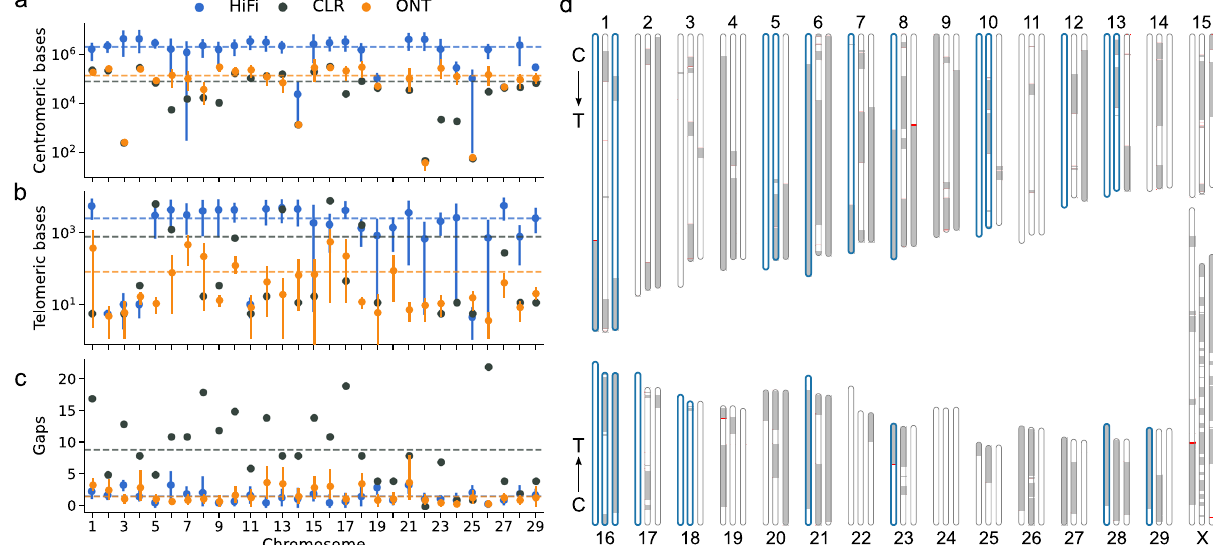
Fig. 2 Centromeric and telomeric completeness of assemblies produced by hi fi asm and Shasta. a The mean number of bases identi fi ed per autosome as “ Satellite ” by RepeatMasker for the n = 5 hi fi asm (blue) and n = 5 Shasta (orange) assemblies, where error bars indicate the 95% con fi dence interval. The black dots represent values from the CLR-based ARS-UCD1.2. Dashed lines indicate the autosome-wide mean for the respective color of points. Mean values of 0 (e.g., chromosome 20) are not shown due to the log scale. b Similar to ( a ), but the number of bases in telomeric repeats within 10 Kb of chromosome ends. c Similar to ( a ), but the number of scaffold gaps. d Chromosome ideograms for ARS-UCD1.2 (center), and Brown Swiss assemblies produced by hi fi asm (left) and Shasta (right). Scaffolded contigs alternate white/gray across gapped regions, which are colored red. Chromosomes which are predicted to extend from centromere to telomere are bolded in blue, of which 7 and 3 are also gapless for hi fi asm and Shasta respectively. Arrows indicate the centromere (C) to telomere (T) directionality of the chromosomes (this applies only to autosomes, as the X chromosome is